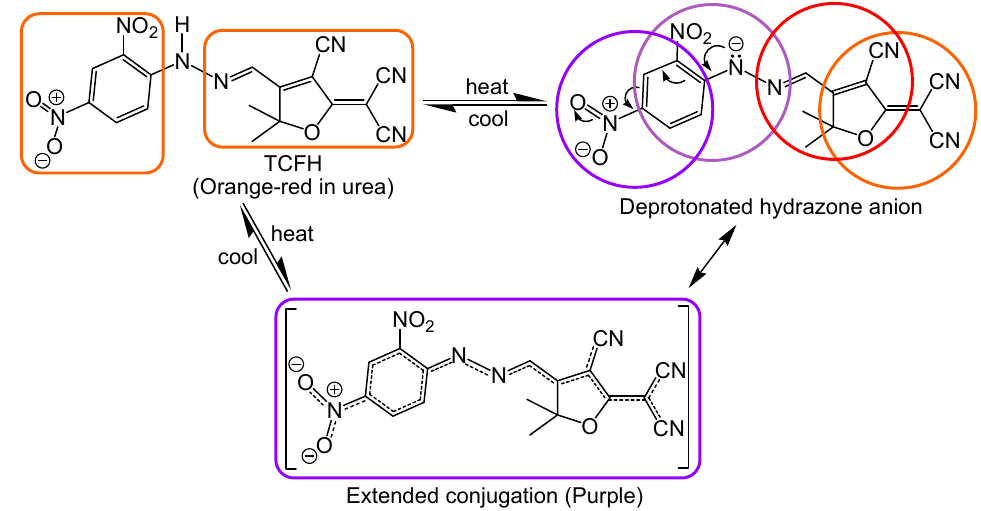
Figure 3. Normalized UV–Vis absorbance spectra of UTCFH (0.06 wt%) in DMSO at different temperature values; 44 °C (yellow at 442 nm), 51 °C (orange at 490 nm), 57 °C (red at 505 nm), and 63 °C (purple at 535 nm).